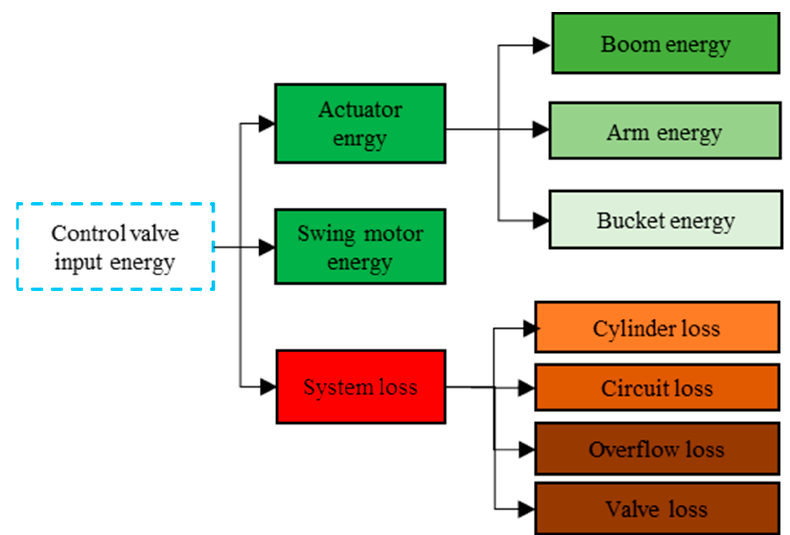
Figure 5. Excavator operation system energy flow.